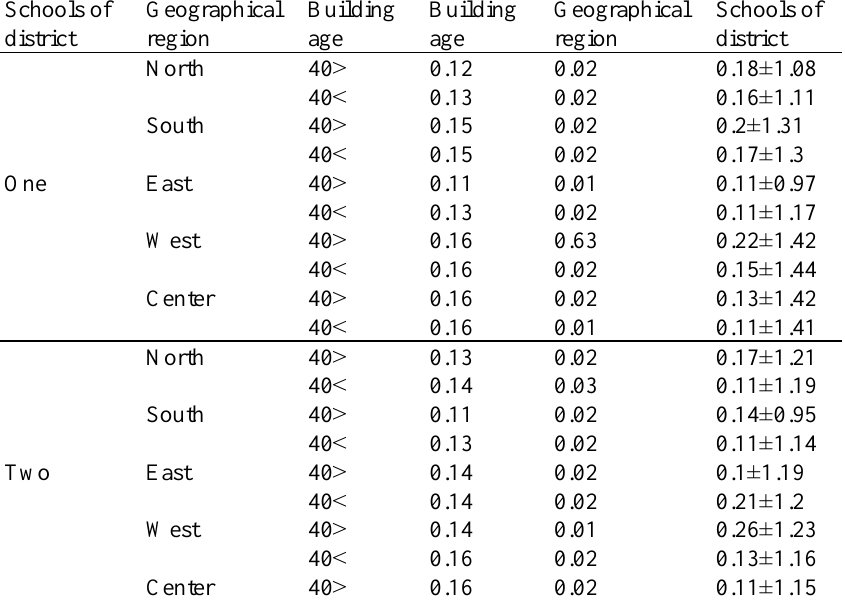
Table 3. Annual dosimetry results of public schools based on age of buildings in district one of Hamadan